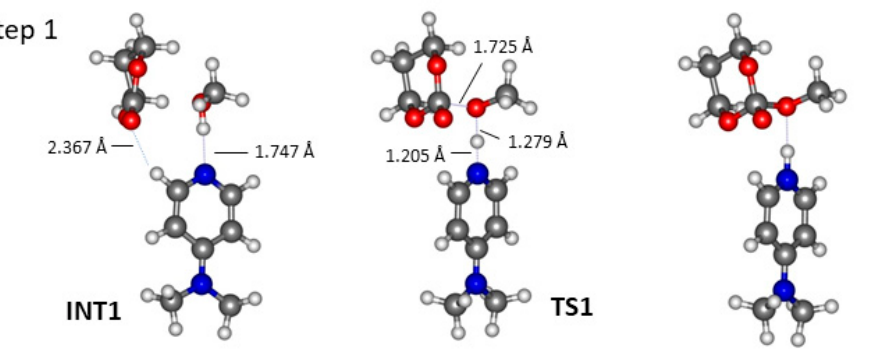
Figure 3. Optimized geometry structures of the species involved in the first step of the H-bond mechanism for the DMAP-catalysed ring-opening polymerization of TMC. Colour code: C grey, O red, N blue and H white.